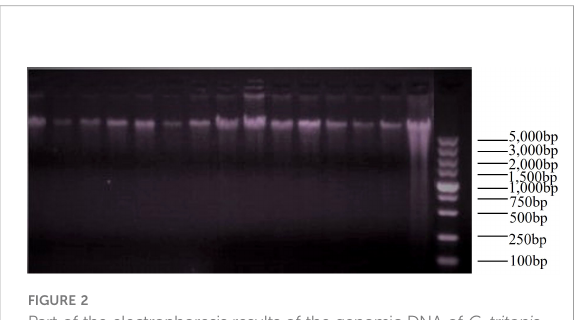
FIGURE 2 Part of the electrophoresis results of the genomic DNA of C. tritonis .